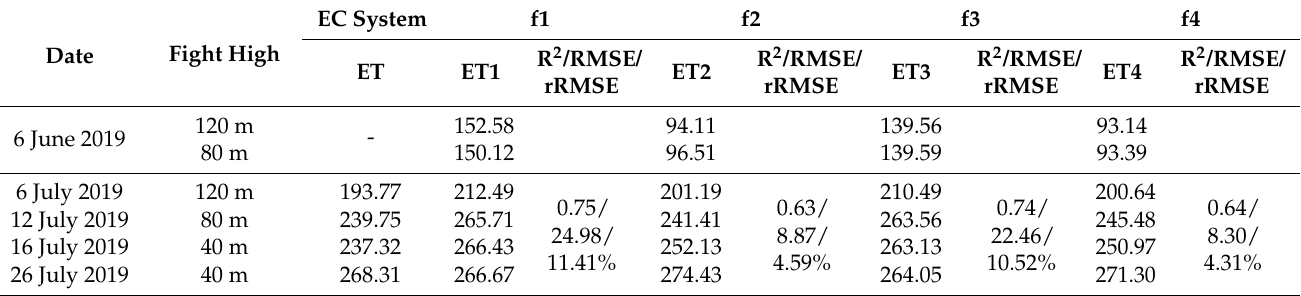
Table 1. The evapotranspiration (W m − 2 ) and accuracy of UAV remote sensing inversion under different